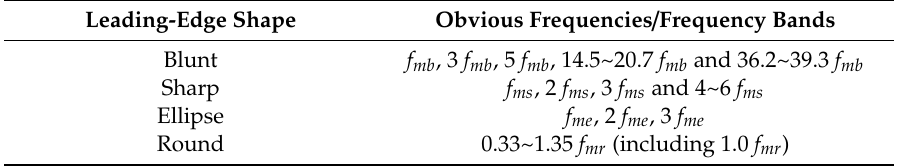
Table 3. Obviously seen frequencies and frequency bands in di ff erent leading-edge shape